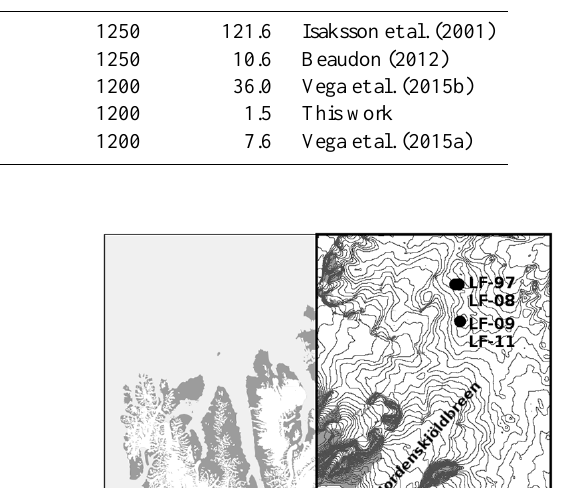
Table 1. Drilling site and ice core description for the four different cores used in this study. Ice core